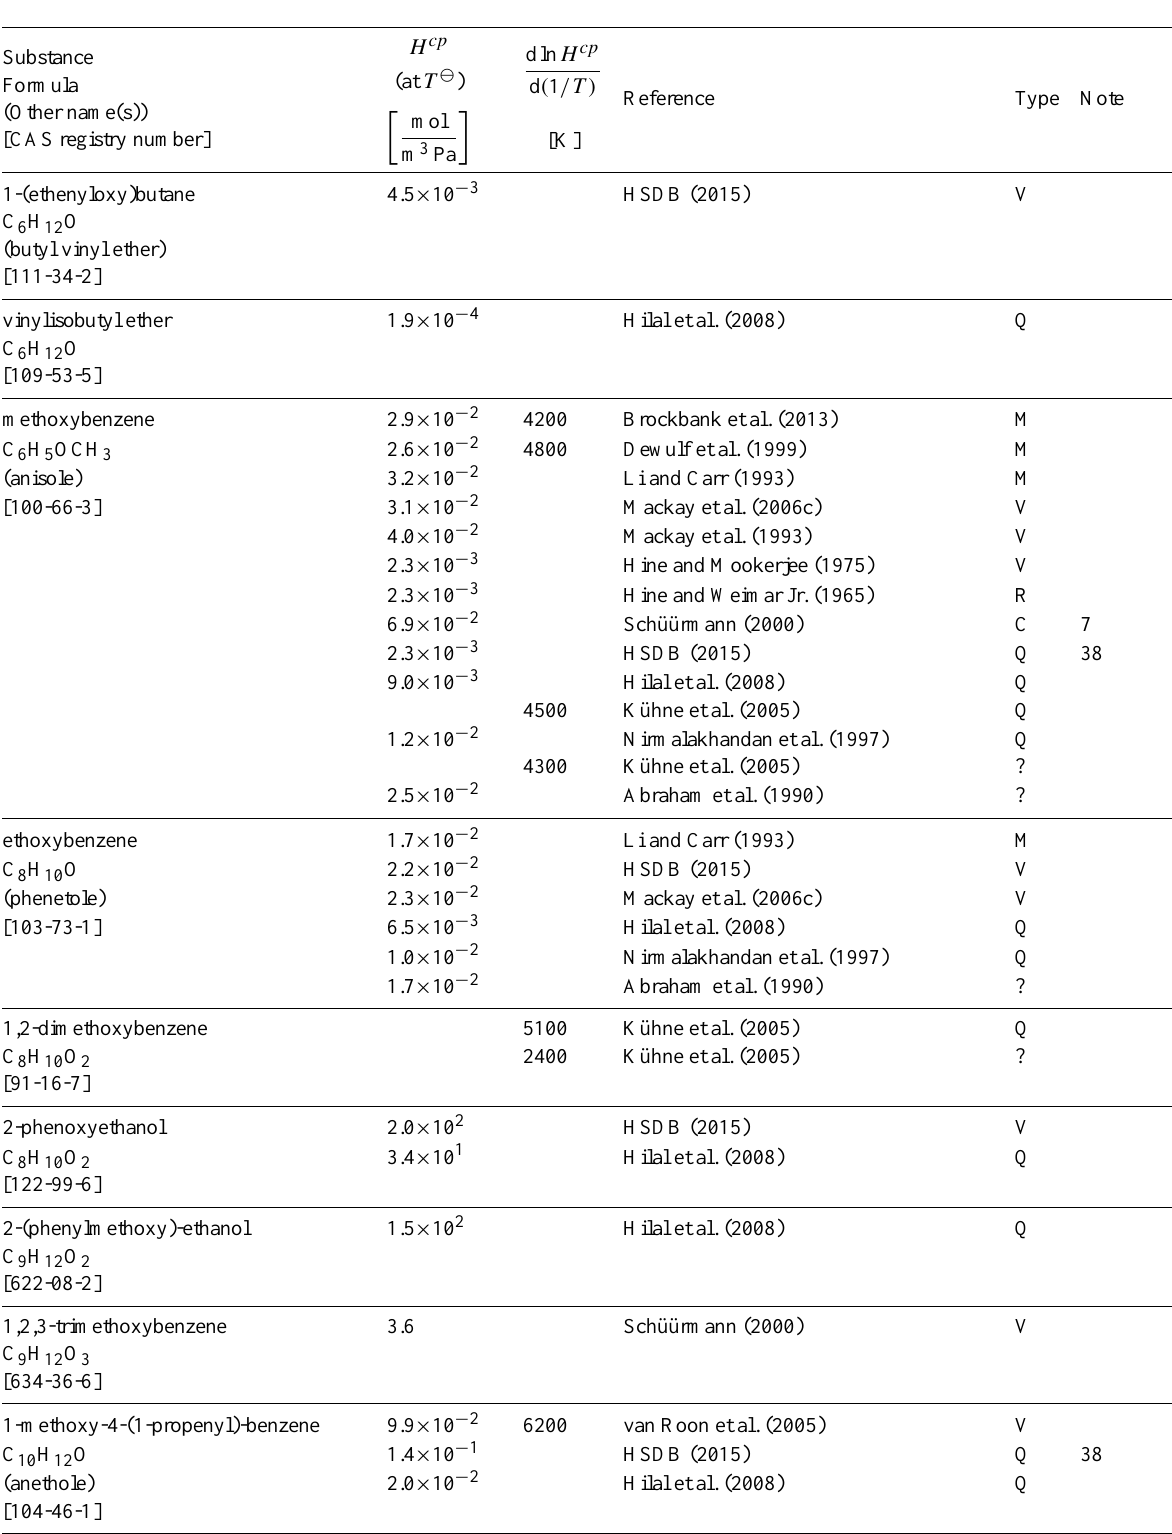
Table 6: Henry’s law constants for water as solvent